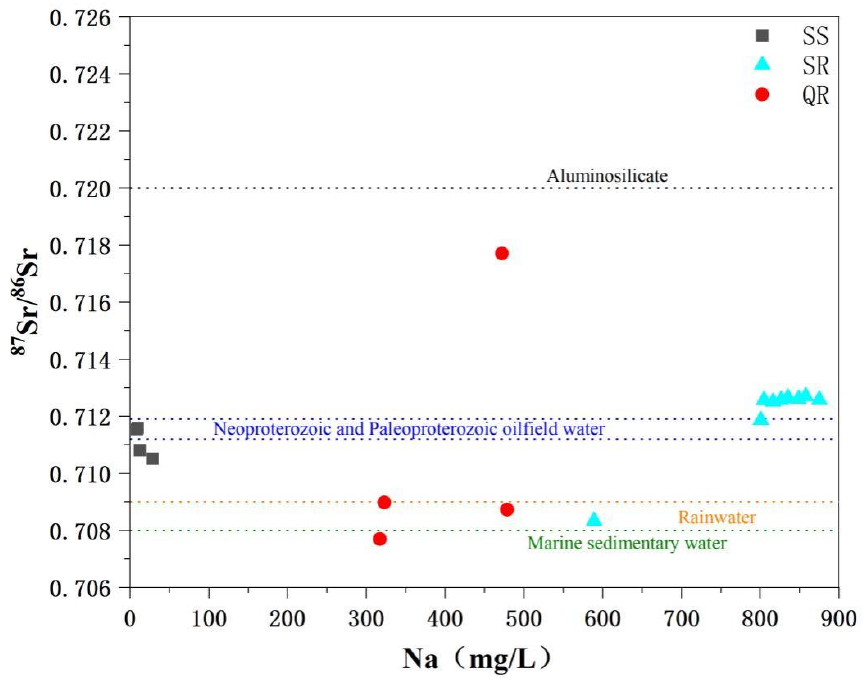
Figure 5. Hydrogen and oxygen isotopic abundance in selected water samples.